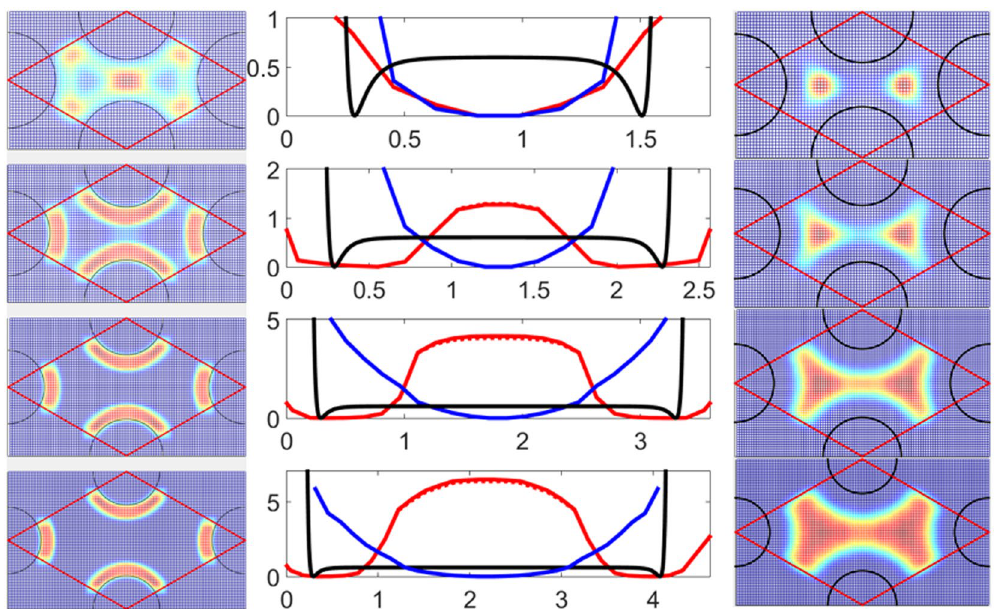
Figure 5. COM probability distribution and potential-of-mean-force between posts. The potential of mean force U eff at distance dr from the post surface across the shortest path between two posts for d/R g = 1.8, 2.6, 3.6 and 4.4 (top to bottom) for purely repulsive posts (blue line) and ε = 0.6 attractive posts (red line). The solid black line shows the post-bead interaction energy, and the dashed line is U eff calculated from half of the data ensemble. The corresponding P ( r COM ) in a unit cell is shown for ε = 0.6 attractive posts (left) and repulsive posts (right). The colors blue to red indicates low to high